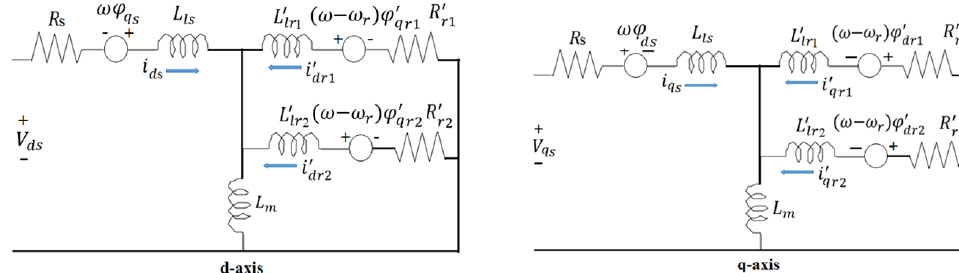
Figure 3. Electrical circuit of a double cage induction machines in the arbitrary two-axis, dq- reference